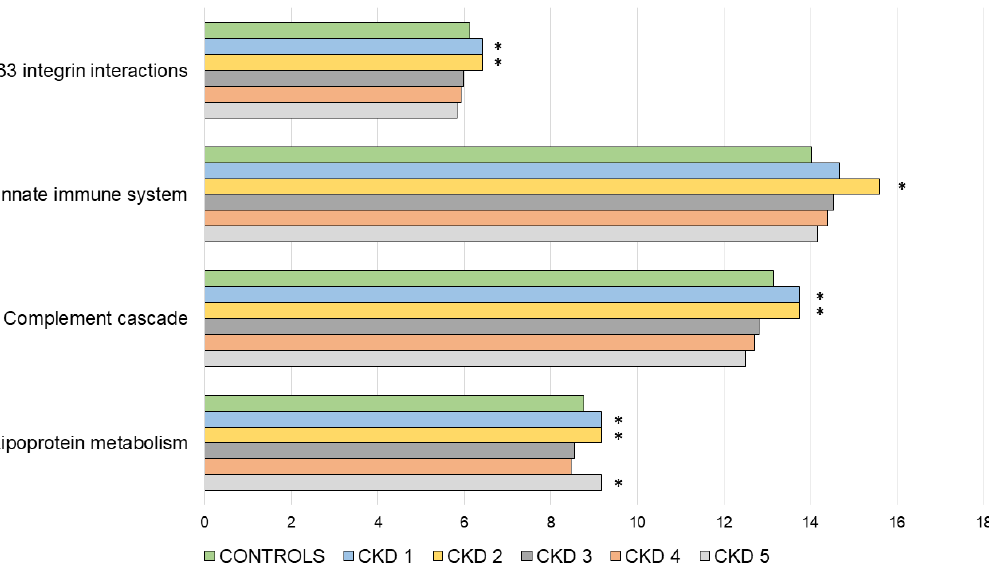
Figure 3. Bar charts showing relevant biological pathways ( Y -axis) and the percentage of identified proteins (i.e., genes) involved in the respective pathway ( X -axis) in each study group. Asterisk (*) denotes the highest group percentage in each analysed pathway.